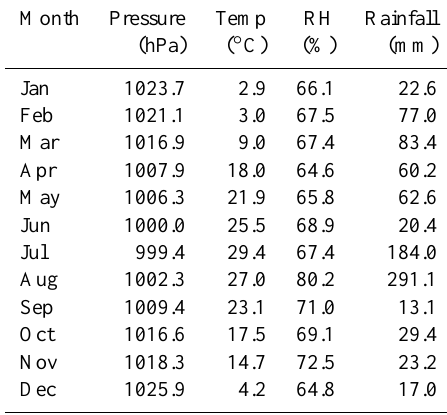
Table 1. Statistics of general meteorological parameters at Nanjing for the 1yr period August 2011–July 2012 ∗